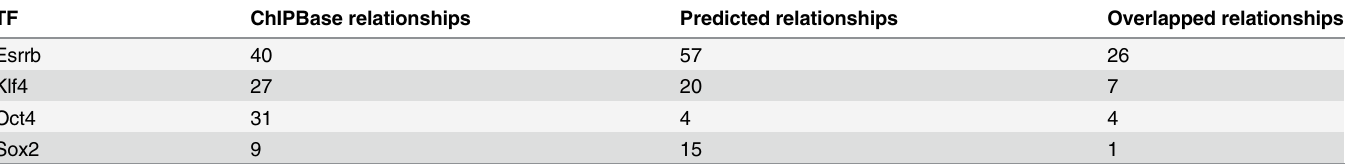
Table 1. Comparison of our final result with ChIPBase relationships of the four TFs: Esrrb, Klf4, Oct4 and Sox2.